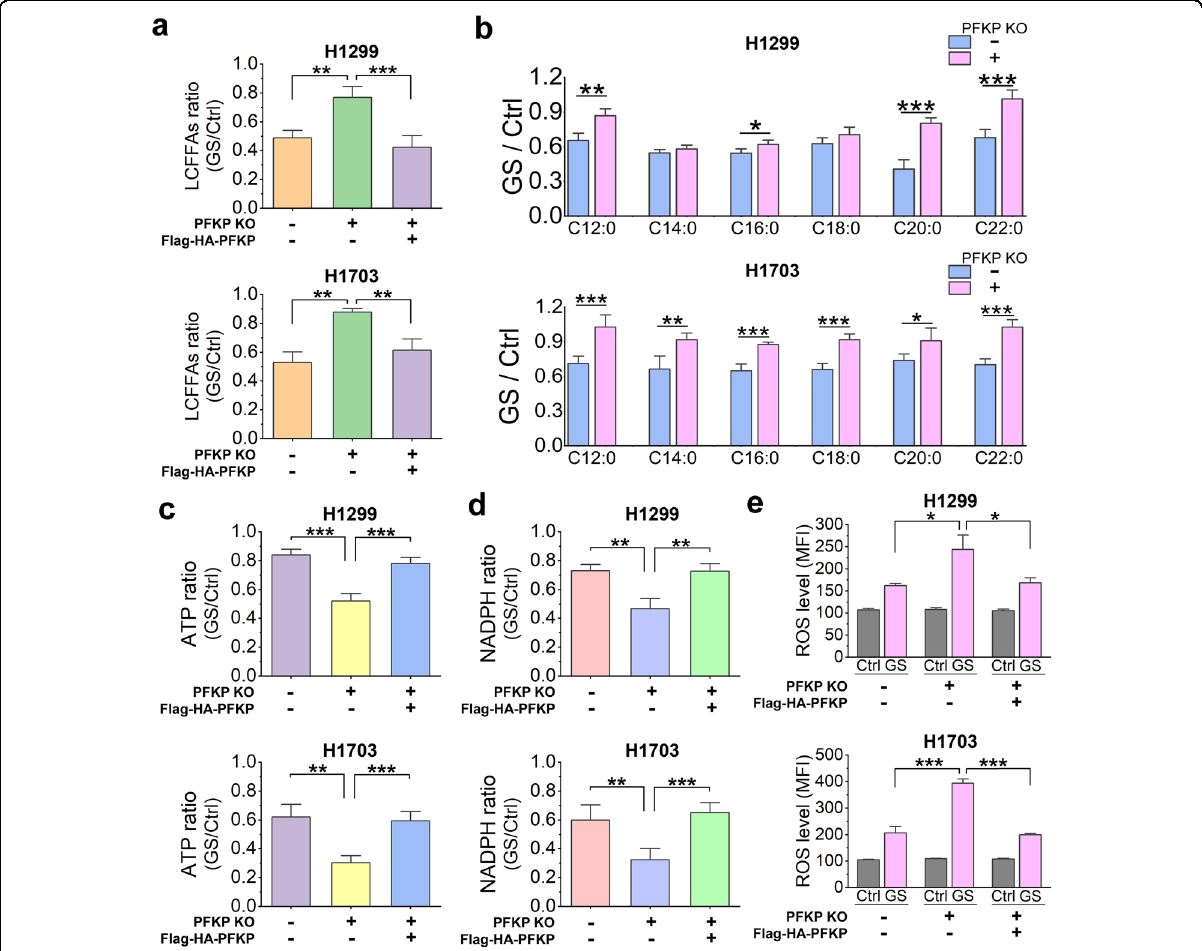
Fig. 5 PFKP promotes long-chain fatty acid oxidation via ACC2 to maintain energy and redox homeostasis. a Relative level of long-chain free fatty acids (LCFFAs) in H1299 ( n = 4) or H1703 ( n = 4) cells under GS for 14 h over that in control. b Relative concentration of lauric acid (C12:0), myristic acid (C14:0), palmitic acid (C16:0), stearic acid (C18:0), arachidic acid (C20:0), and behenic acid (C22:0) in H1299 ( n = 4) or H1703 ( n = 5) cells under GS for 14 h over that in control. c – e Relative ATP ( c , n = 4), NADPH ( d , n = 4), and ROS level ( e , n = 6) in H1299 or H1703 cells under GS for 14 h over that in control (Ctrl). Data are shown as means ± SD with n indicating the number of biological replicates. * P < 0.05, ** P < 0.01, *** P < 0.001 by two-tailed Student ’ s t